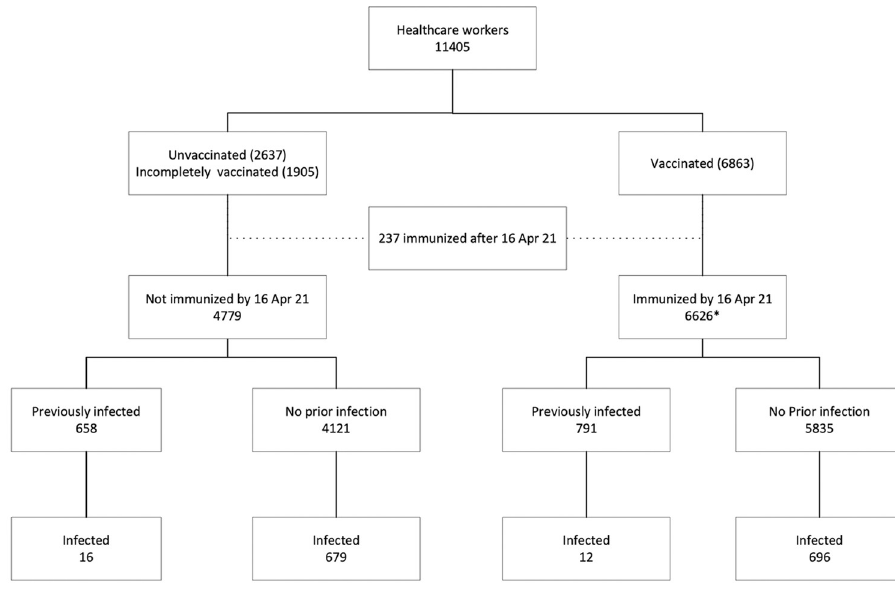
Fig 1. Flow diagram. � received two doses of vaccine by 2 nd April 2021.